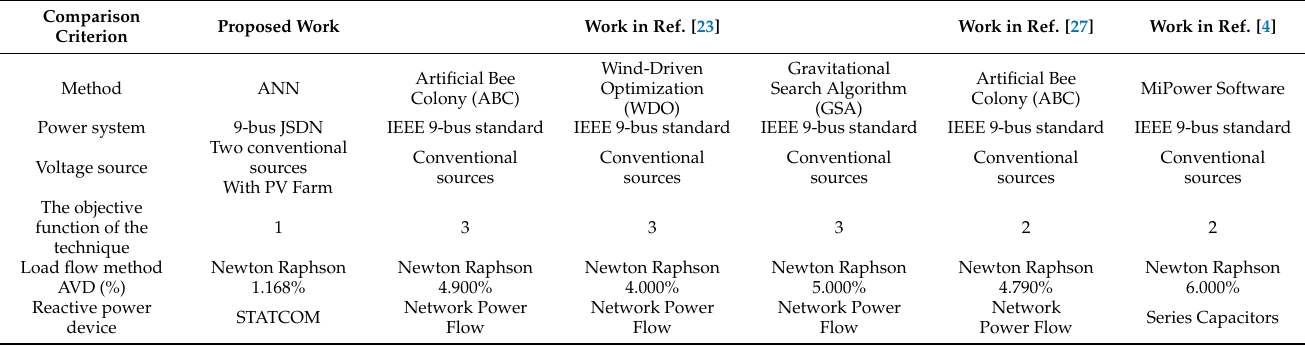
Table 1. A Comparison between the proposed ANN and different control